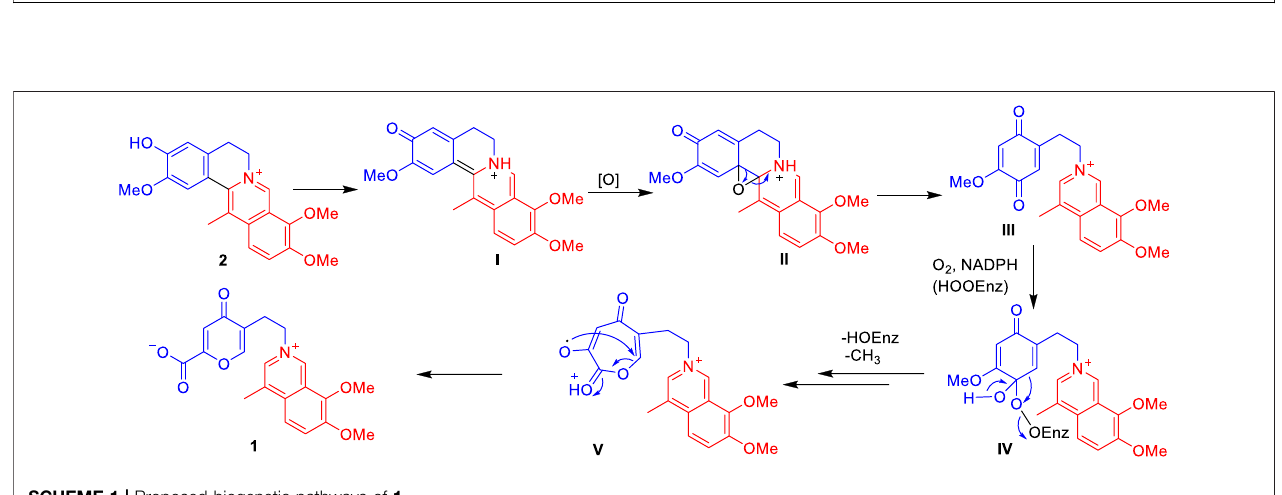
FIGURE 3 | Molecular simulation docking results of 1 with AChE.